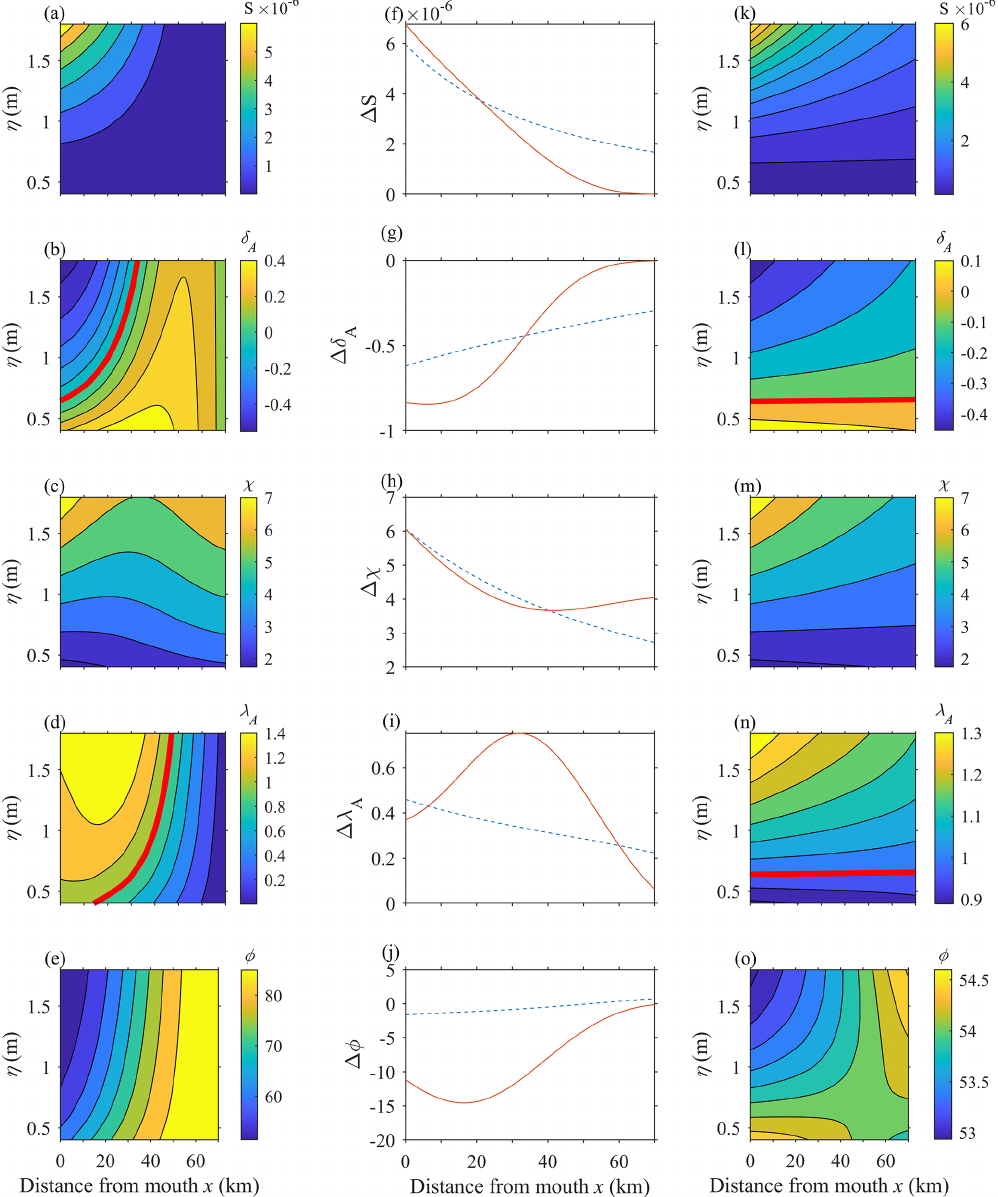
Figure 9. Tidally averaged slope ( S ) and main dimensionless parameters describing the tidal propagation along the Guadiana Estuary in function of the tidal amplitude at the mouth ( η 0 ; metres). The damping number for the water level ( δ A ), the friction number ( χ ), the celerity number for water level ( λ A ), and the phase angle between velocity and elevation ( φ ) are shown. The left column (a–e) and the right column (k–o) represent the results for a semi-closed channel and an infinite channel, respectively. The middle column (f–j) represents the spring-neap difference for each parameter ( (cid:49)S , (cid:49)δ A , (cid:49)λ A , and (cid:49)φ , respectively). The thick red lines presented in subplots (b) and (l) correspond to δ A = 0. In subplots (d) and (n) , they correspond to λ A =